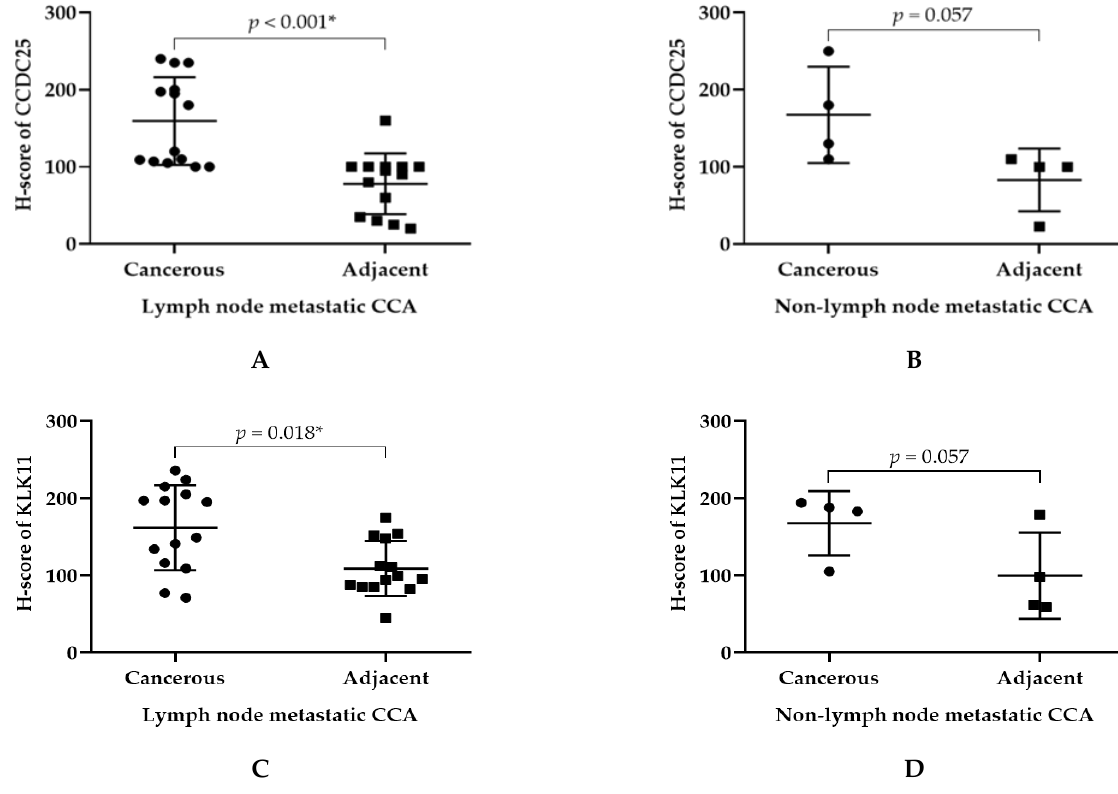
Figure 3. H-score of CCDC25 and KLK11 in lymph node metastatic CCA and non-metastatic CCA. ( A ) H-score of CCDC25 in lymph node metastatic CCA. ( B ) H-score of CCDC25 in non-lymph node metastatic CCA. ( C ) H-score of KLK11 in lymph node metastatic CCA. ( D ) H-score of KLK11 in non-lymph node metastatic CCA. Mann–Whitney U test was used to compare H-score between cancerous and adjacent tissues of CCDC25 and KLK11. * Statistical significance ( p <